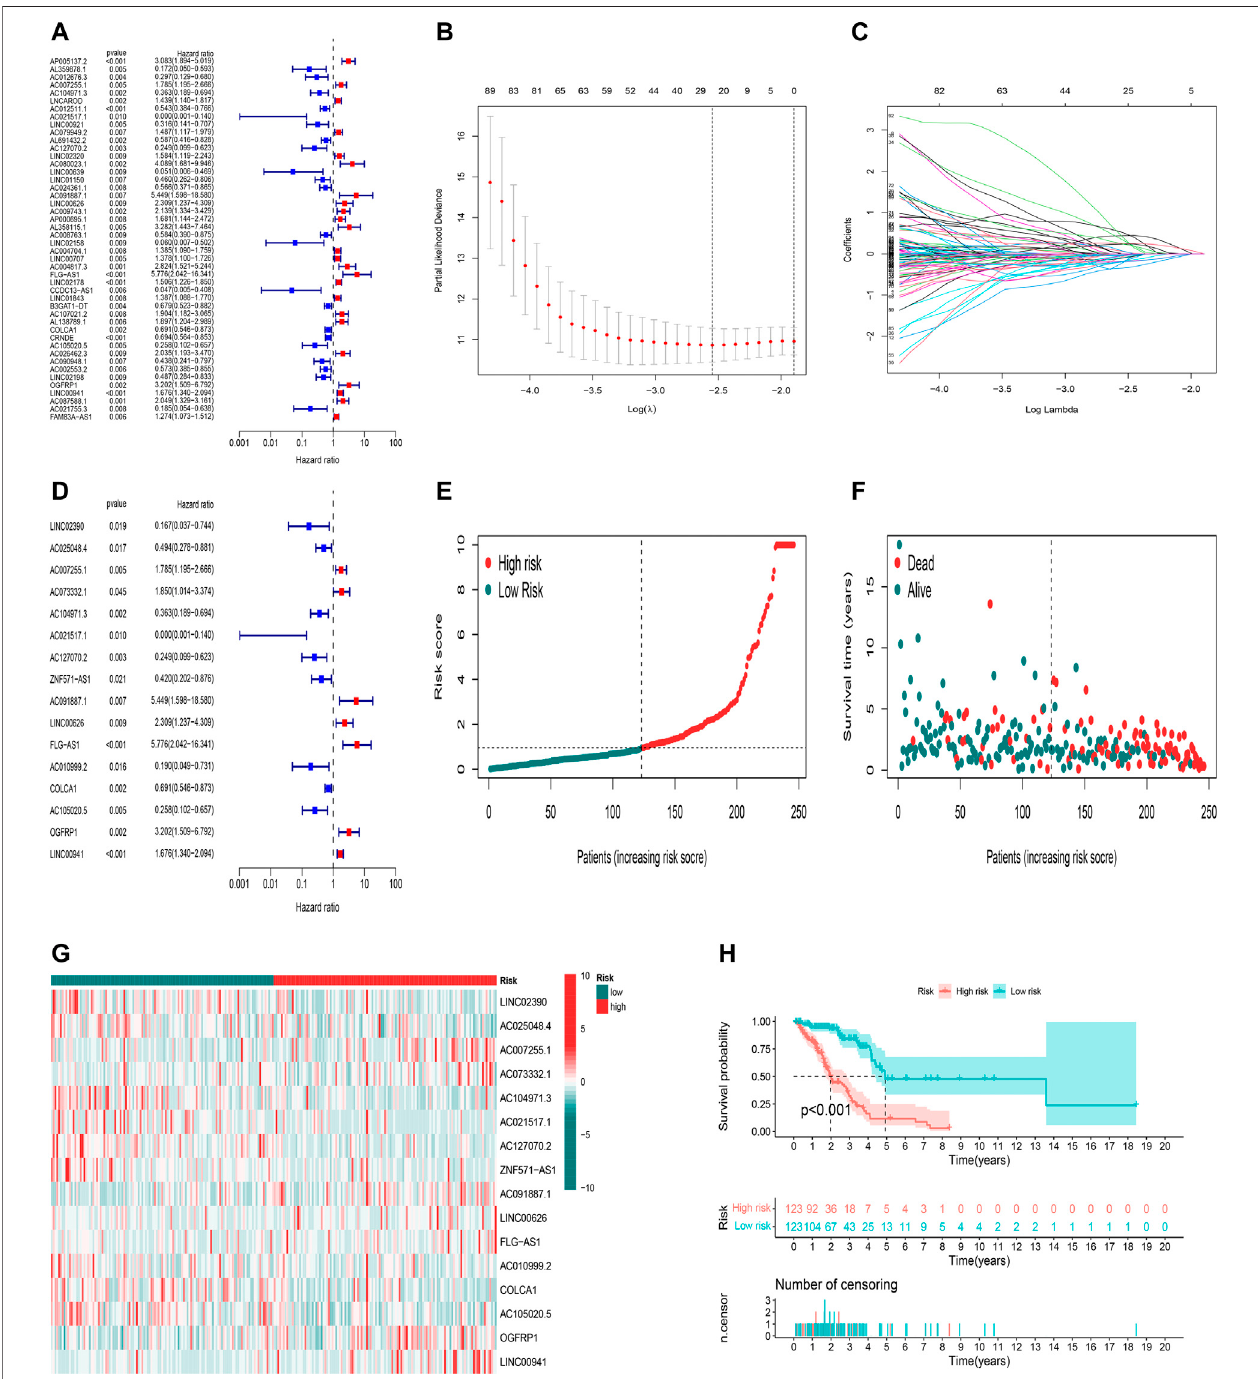
FIGURE 3 | Construction and validation of the predictive model in TCGA training set. (A) Univariate Cox regression analysis of OS for part of 182 oxidative stress- related lncRNA prognostic signatures. (B,C) Altogether 25 lncRNAs were selected using LASSO regression. (D) Multivariate Cox regression analysis showed 16 independent prognostic lncRNAs. (E) Distribution of oxidative stress-related lncRNA model-based risk score for the training set. (F) Different patterns of survival status and survivaltime betweenhigh-riskand low-riskgroups in thetraining set. (G) Heatmap toshow theexpression of16lncRNAs betweenhigh- and low-riskgroups in the training set. (H) Kaplan – Meier curve of high-risk and low-risk patients in the training set.